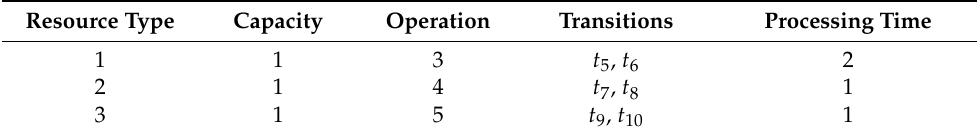
Table A2. Data for Operations, Transitions and Resources involved in Type-2 Tasks.